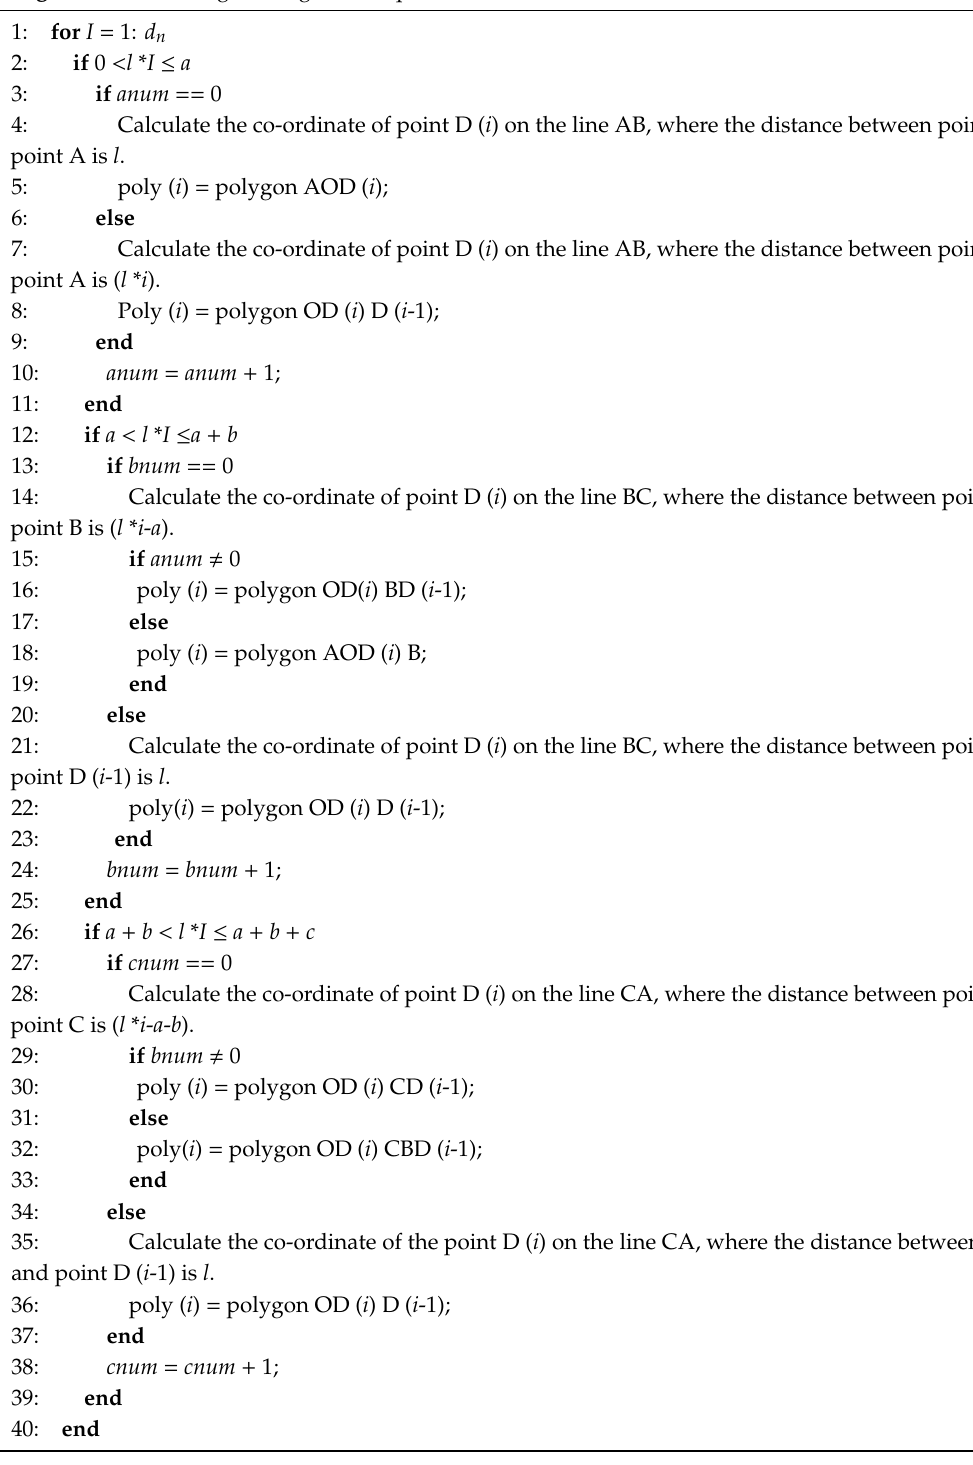
Algorithm 1 Dividing a triangle into equal